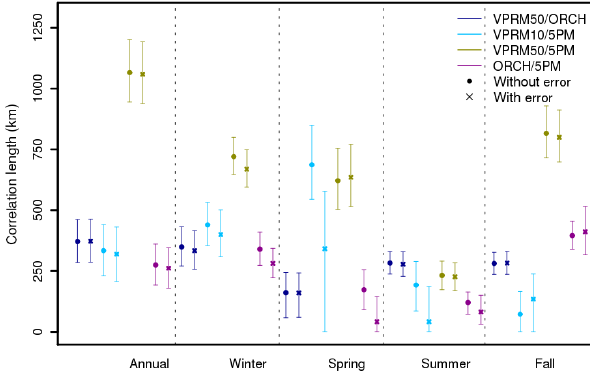
Figure 9. Annual and seasonal e-folding correlation length for an ensemble of daily averaged NEE differences between two models without (filled circle) and with random measurement errors added to the modelled fluxes used as reference (crosses). The symbols rep- resents the best-fit value when fitting the exponential model, and the upper and lower edge of the error bars show the 2.5 and 97.5 per- centiles of the correlation length. The first acronym at the legend represents the model used as reference and the second the model which was compared with. Note that for the VPRM10/VPRM1 case during spring (with and without random error), the 97.5 percentile of the length value exceeds the y axis and has a value of 1073, 1626km